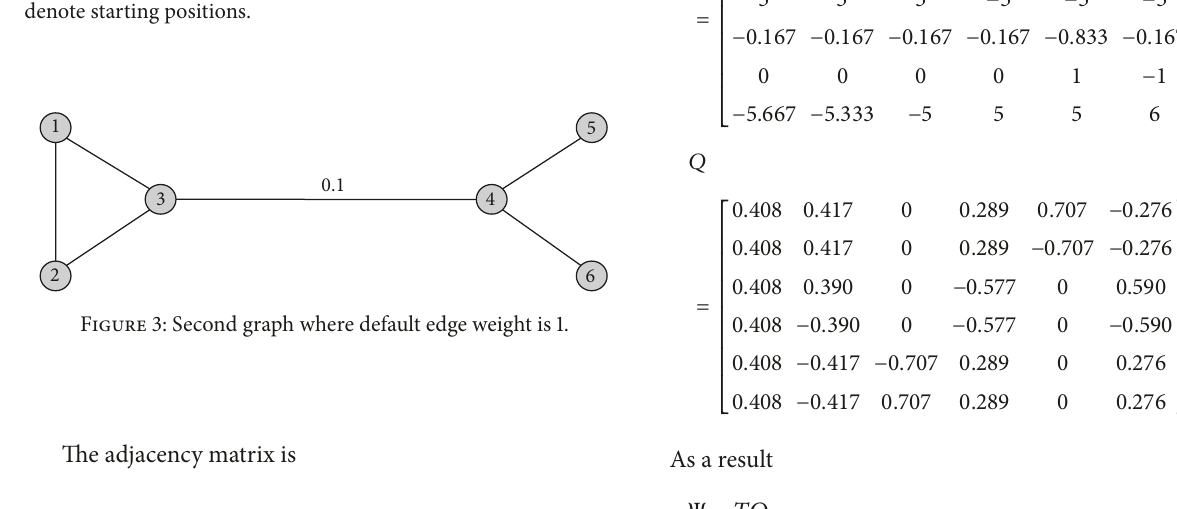
The adjacency matrix